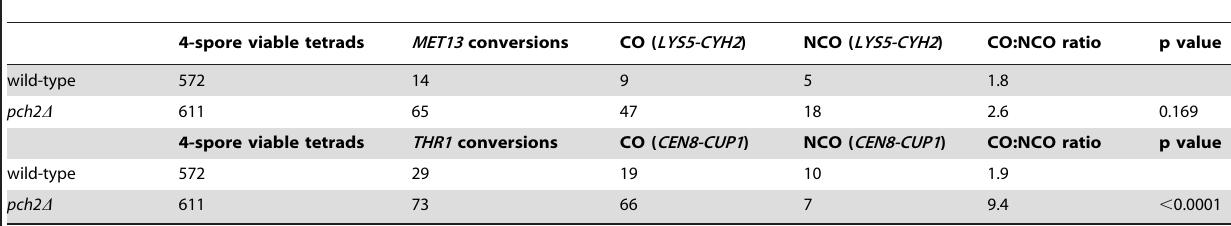
Table 3. CO:NCO ratio of markers flanking gene conversion events on chromosomes VII and VIII.